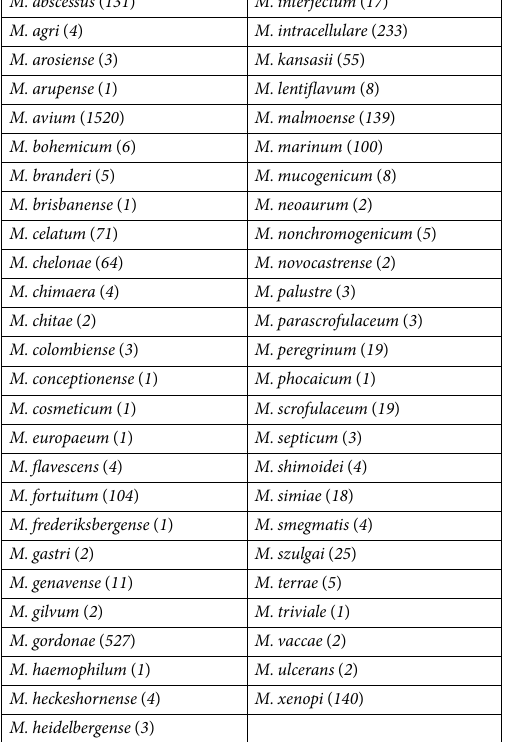
Table 4. NTM species cultured from human specimens at IRLM 1991–2015, n = 51. (Uidentified mycobacteria n =